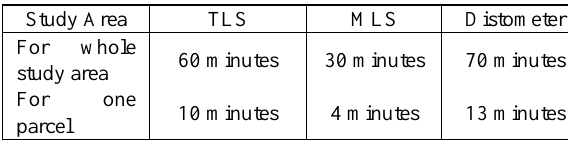
Table 3. Time taken for study area based on different